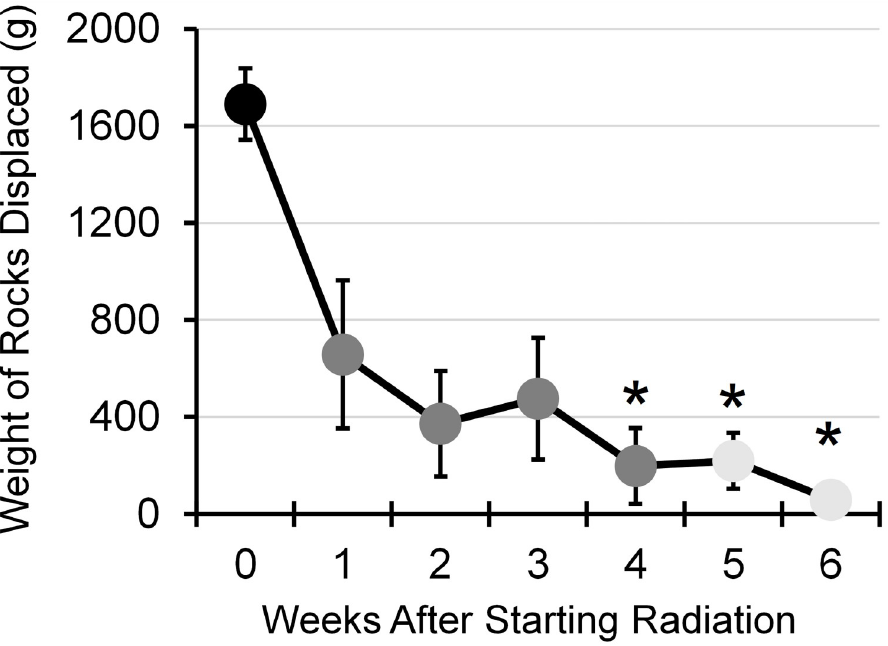
Fig 1. Burrowing behavior after radiation treatment. The graph shows the time course of change in the mean weight of rocks displaced. Data was analyzed using a repeated measures ANOVA to compare baseline (0; black), during treatment (1–4 weeks; grey), and after treatment (5 & 6 weeks; light grey). An asterisk indicates a statistical significance of p < 0.05 compared to